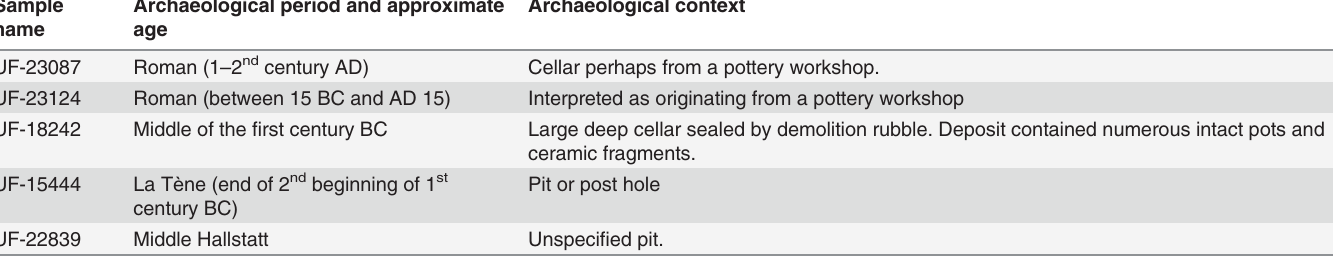
Table 1. Summary of the archaeological sediments examined for